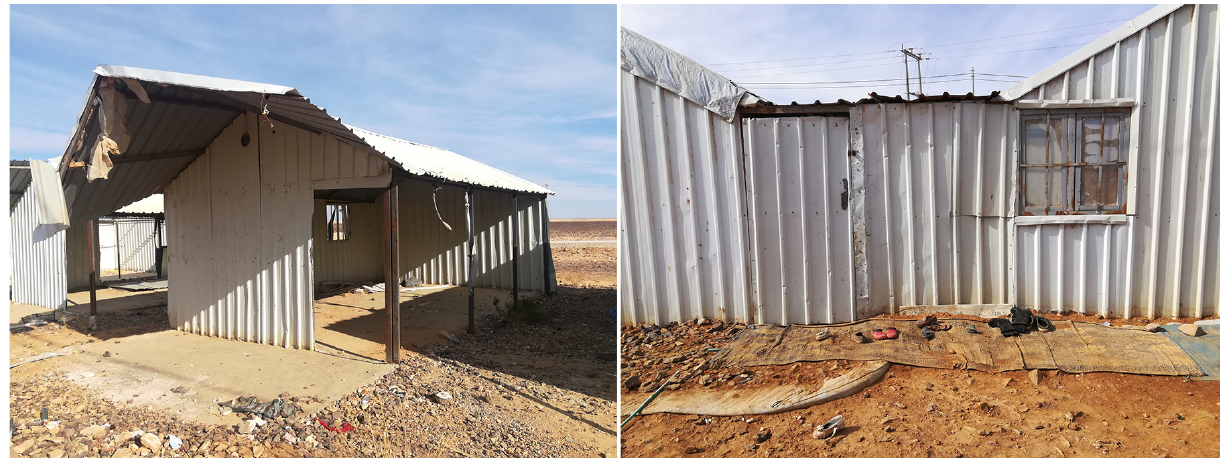
Figure 4. The vandalization of uninhabited shelter units to appropriate inhabited ones and connect them to create addi- tional spaces. Source: Dalal taken in